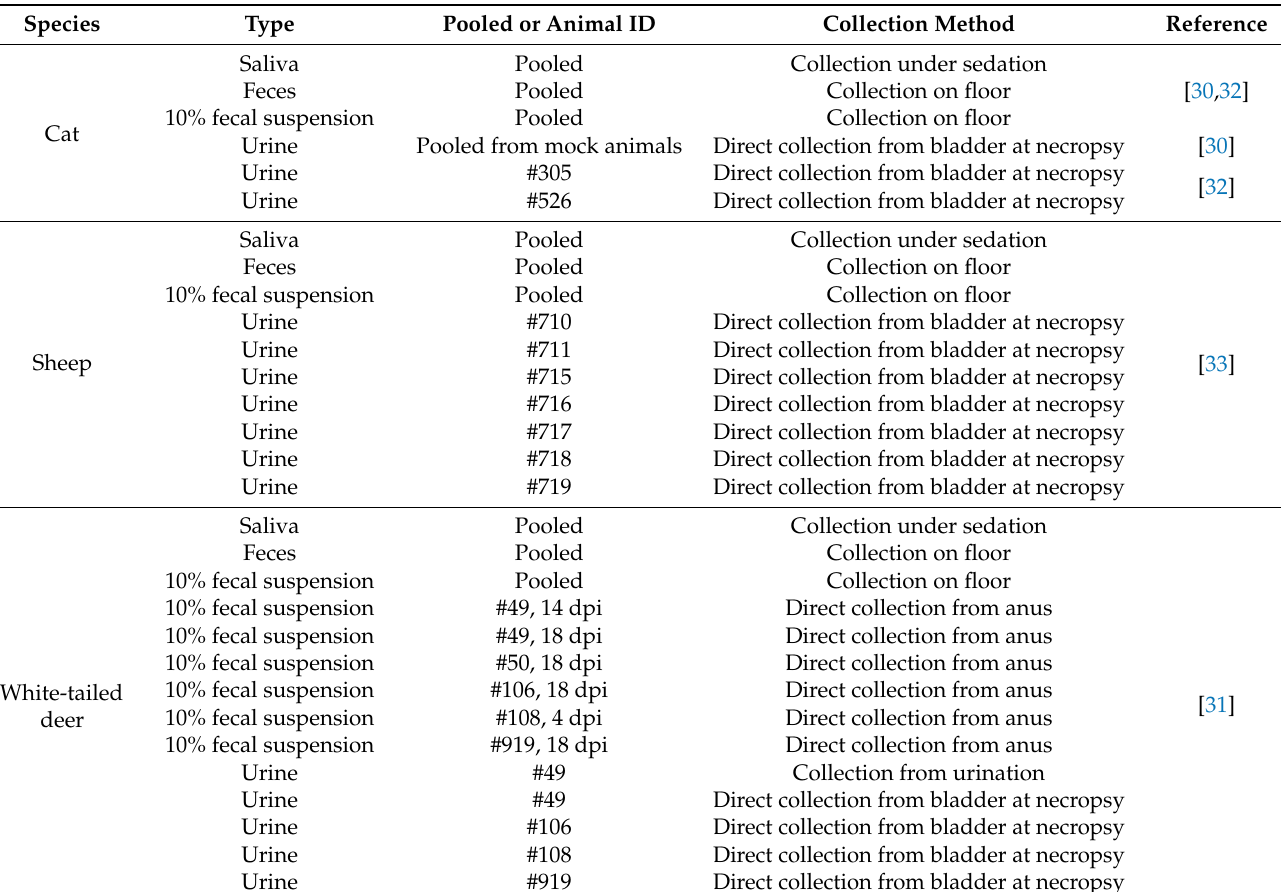
Table 1. List of biological fluids from cats, sheep, and white-tailed deer that were used in this